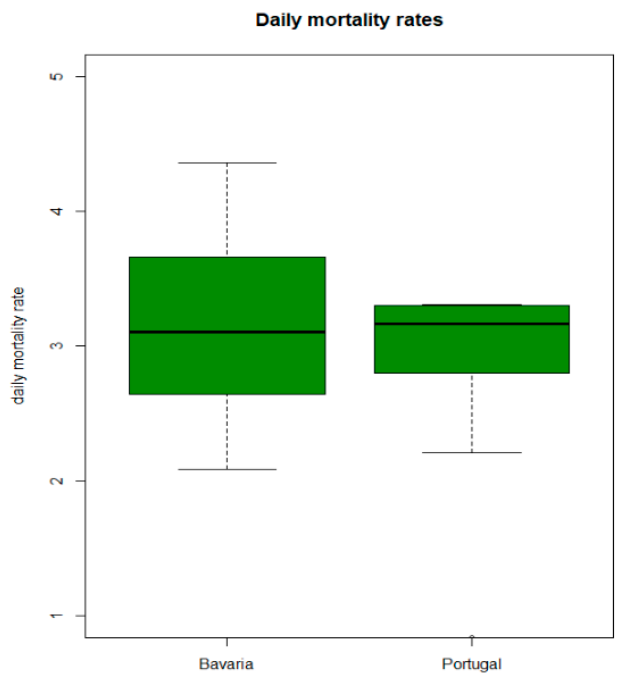
Figure 6. Daily crude mortality rates (per 100,000 inhabitants) as mean over the months April to September 2003–2017 for each of the 15 cities/ counties of Bavaria (left box) and 14 municipalities of Portugal, respectively (right box).